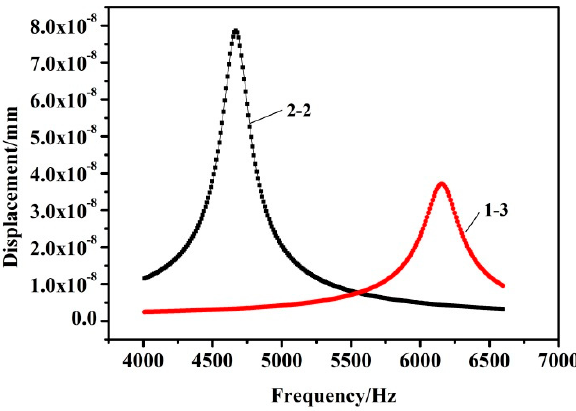
Figure 7. Vibration displacement curves of the 2 ‐ 2 and 1 ‐ 3 type piezoelectric composite bilaminated vibrators.